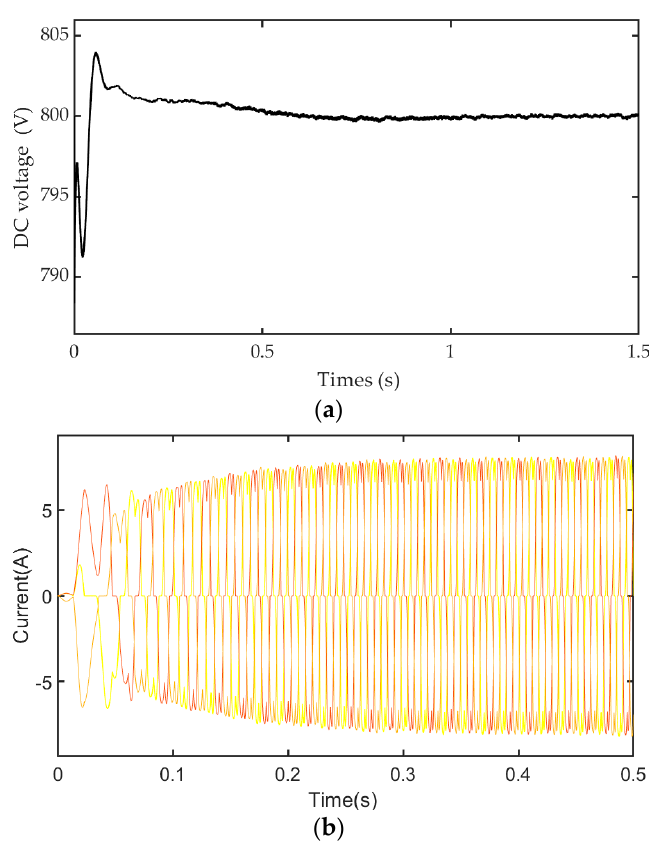
Figure 19. System block diagram. ( a ) The torque curve; ( b ) The speed curve; ( c ) The rotor angle curve; ( d ) The current curve.